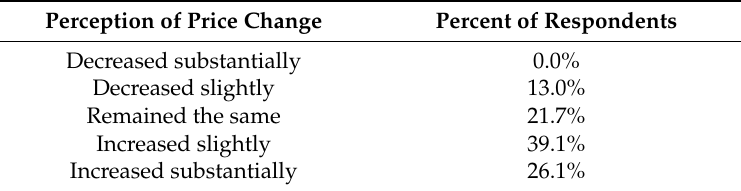
Table 2. Public perception of price changes over the past two years ( n =